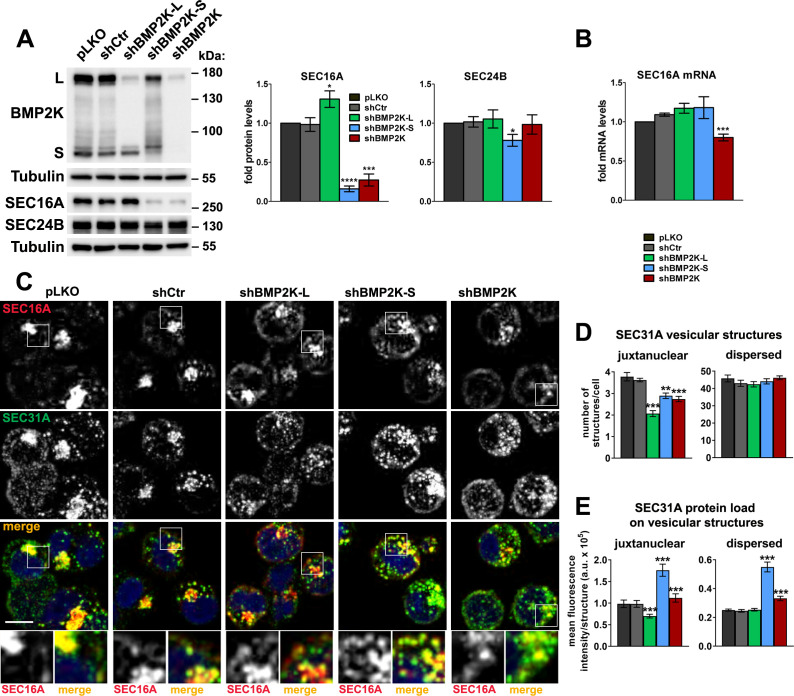
BMP2K splicing variants differentially regulate SEC16A protein levels and distribution and control the abundance of SEC31A-positive structures.(A) Western blots showing the effect of shRNA-mediated depletion of single (shBMP2K-L or shBMP2K-S) or all BMP2K splicing variants (shBMP2K) on the levels of SEC16A and SEC24B proteins, as compared to empty pLKO vector or non-targeting shRNA construct, shCtr. Graphs show densitometric analysis of western blotting bands for the indicated proteins using tubulin abundance for normalization (n = 5 +/- SEM). (B) SEC16A mRNA fold levels in control cells or in cells with shRNA-mediated depletion of BMP2K variants (n = 5 +/- SEM). (C) Representative maximum intensity projection images from confocal microscope, showing the effect of shRNA-mediated depletion of BMP2K variants on immunolocalization of SEC16A and SEC31A proteins in K562 cells. Cell nuclei marked with DAPI stain (blue). Insets: Magnified views of boxed regions in the main images. Scale bar, 10 µm. (D and E) The number of juxtanuclear and dispersed SEC31A-positive vesicular structures per cell (D) or SEC31A mean fluorescence intensity per vesicular structure (SEC31A protein load) presented in arbitrary units (a.u. in E) in control cells or cells lacking BMP2K variants. Quantification from images represented by those in C (n = 5 +/- SEM). *p<0.05, **p<0.01, ***p<0.001, ****p<0.0001.Figure 3—source data 1.Numerical data for graphs in Figure 3.